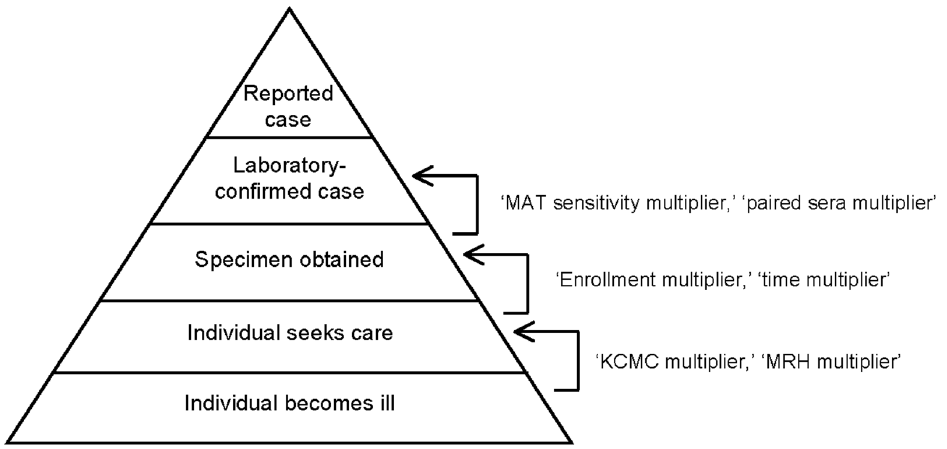
Figure 2. Surveillance pyramid. Multipliers were applied to account for incomplete assessments at various levels of the surveillance pyramid.